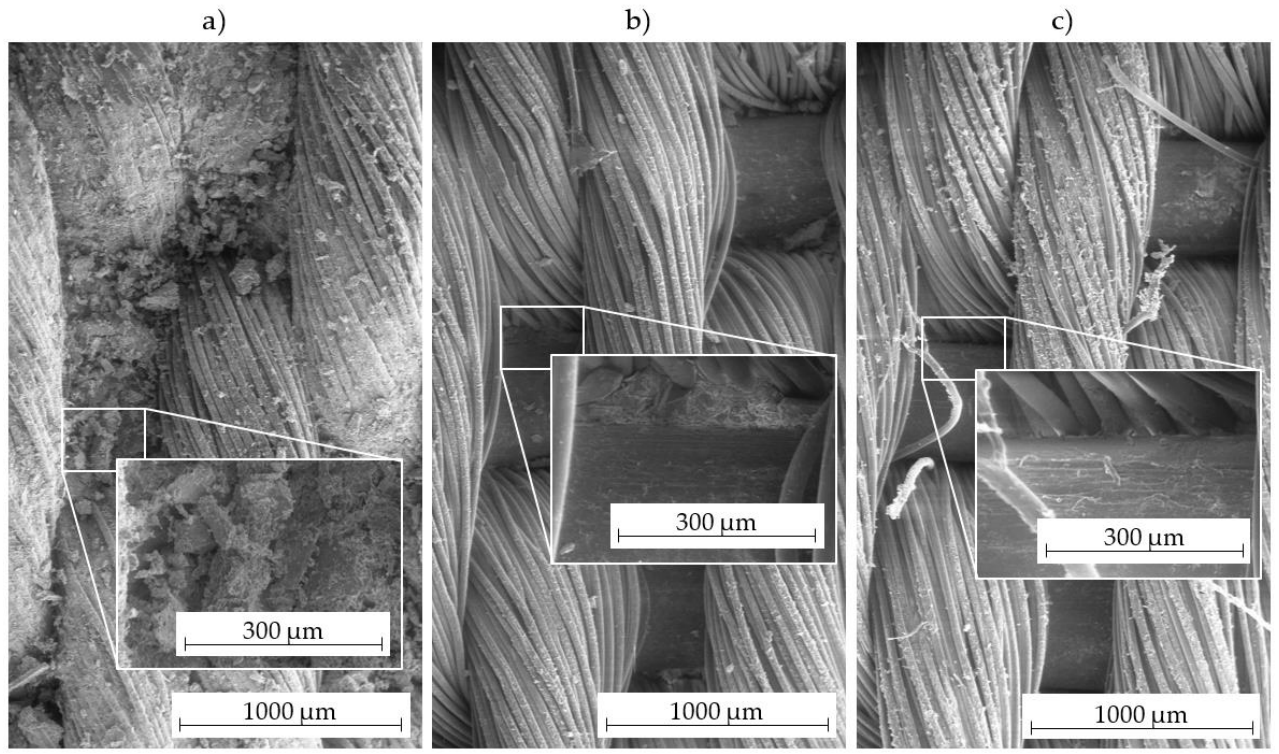
Figure 6. SEM images (80×) of different filter cloth states. ( a ) Insufficient cleaning resulting in a resistance of 3.24 × 10 10 m −1 . ( b ) Threshold cleaning (resistance 2.20 × 10 9 m −1 ). ( c ) Excessive cleaning causing the fraying of multifile fibers (resistance 1.94 × 10 8 m −1 ).